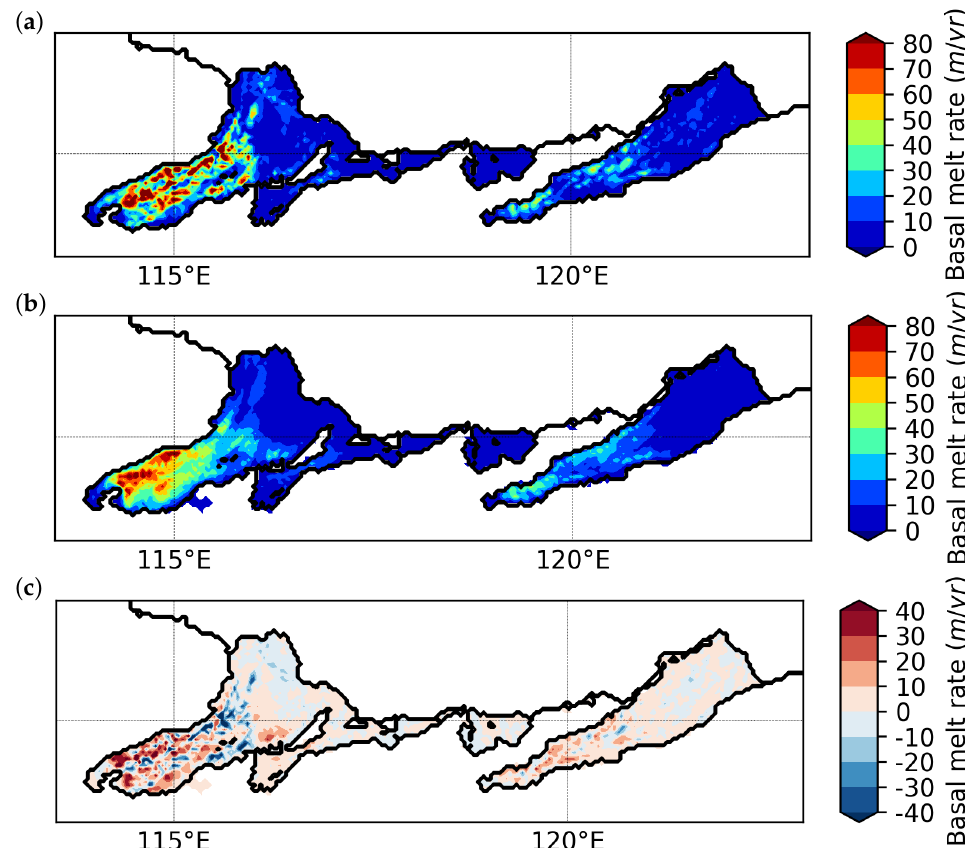
Figure 14. Spatial distributions of the mean basal melt rate for the WARM ( a ) and WARM3mcpl ( b ) simulations over the 2081–2100 period. Differences in basal melt rate between WARM3mcpl and WARM, averaged over the 1995–2014 period ( c